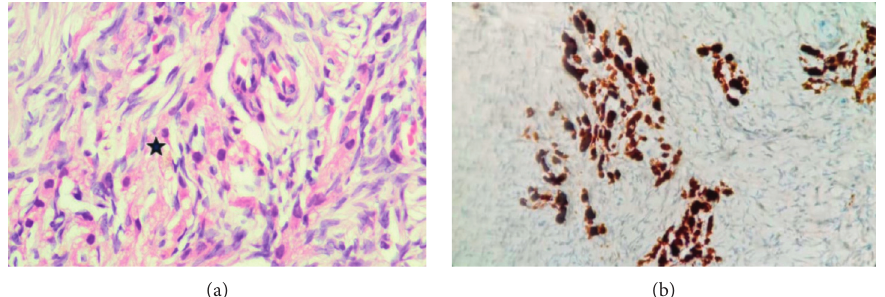
Figure 1: Histology of right ovary showing small clusters of Leydig cells, which has oval round nuclei with inconspicuous nucleoli and moderate eosinophilic cytoplasm (a, asterix, H&E, 400x). The Leydig cells display strong cytoplasmic staining with Calretinin (b, 400x). Histological appearance of the left ovary was similar.